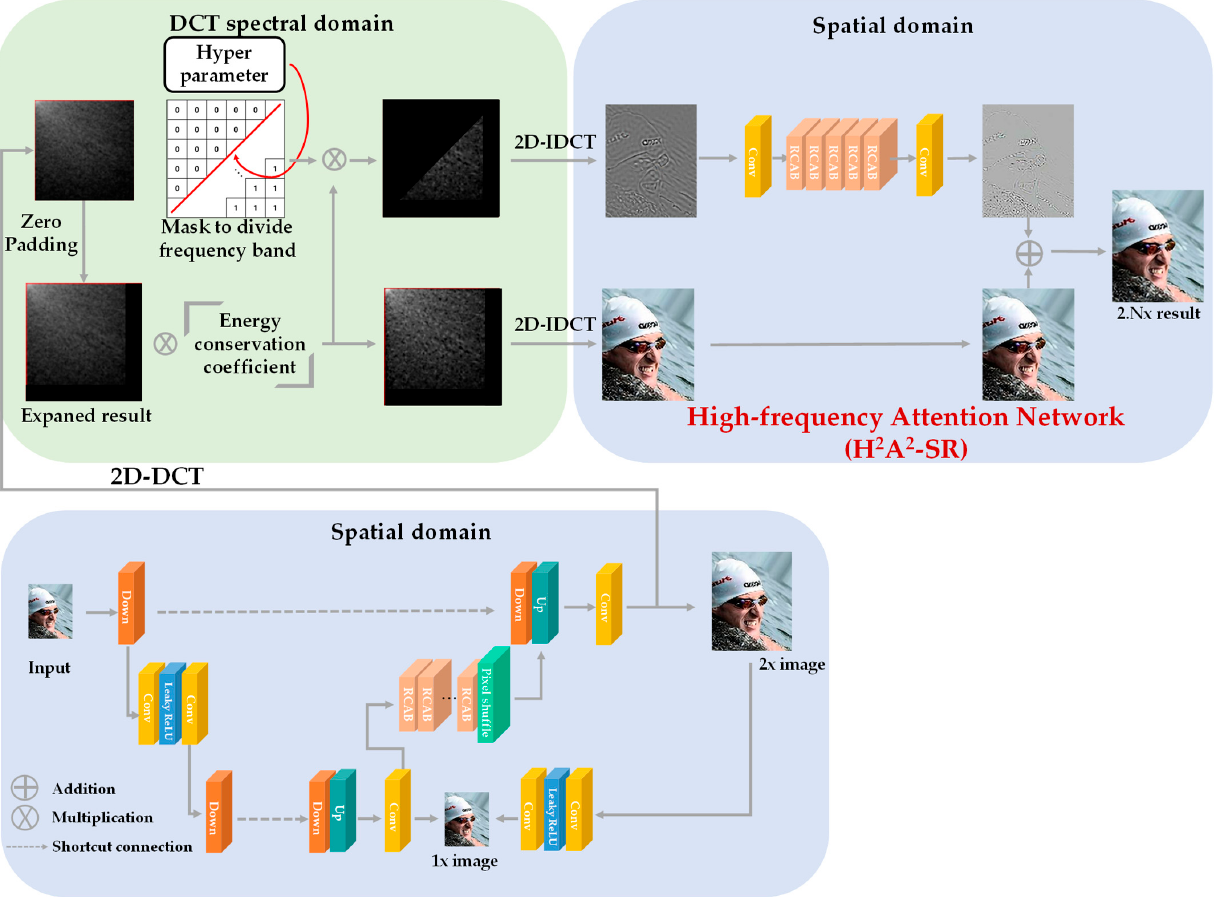
Figure 7. Overall organization of the proposed H 2 A 2 -SR model.